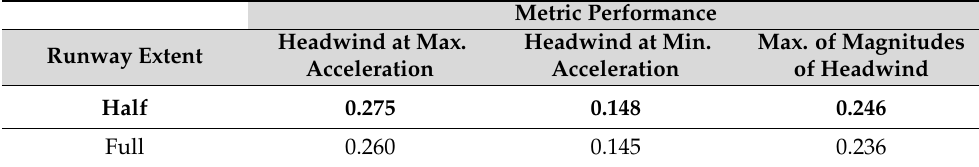
Table 7. Sensitivity of the quantitative indicator of performance (better performance indicated in bold with +1 indicative of ideal performance) to the horizontal extent of data included in ROC calculations. The full runway length or the half-runway extent is based on direction of approach. 07RA runway corridor, typical met, horizontal acceleration, 40 min wind-shear time window. Metric Performance Headwind at Max. Headwind at Min. Runway Extent